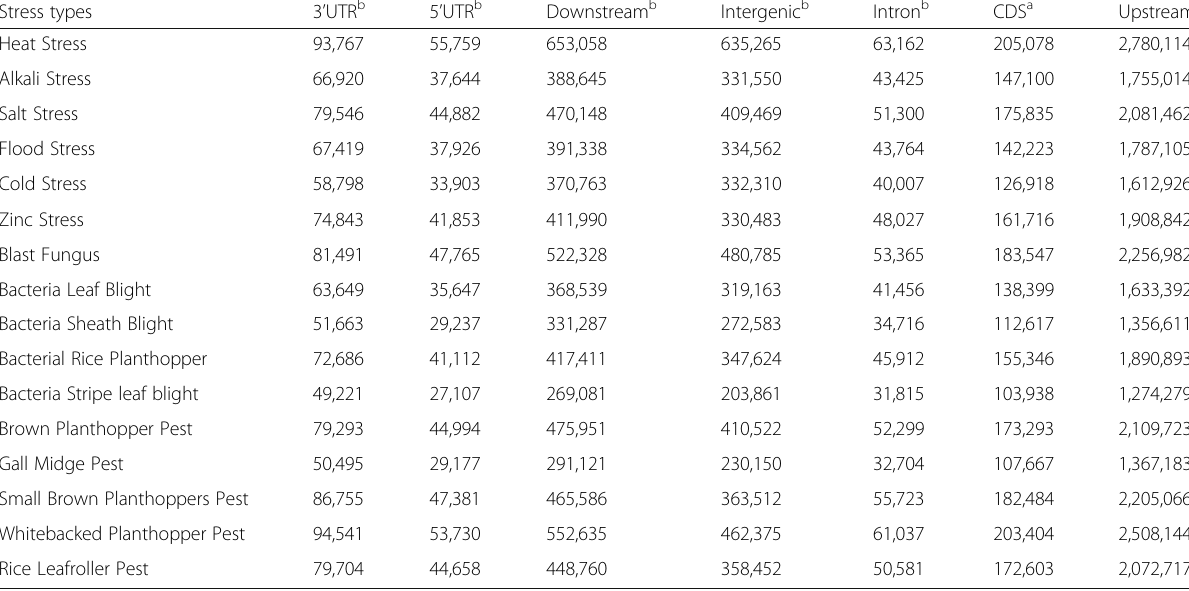
Table 1 Number of stress-resistant SNPs located in different regions of rice genome Stress